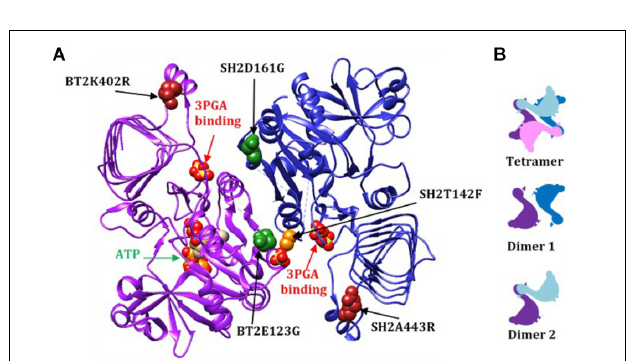
FIGURE 2 | (A) A dimer from the AGPase crystal structure (dimer 1), viewed from the inside of the tetramer demonstrating how the two G α G motifs relate to the two 3PGA binding sites. The 3PGA binding sites are defined by the pair of sulfates from the crystal structure indicated by the red arrows. Here the subunits are designated BT2 (purple ribbon) and SH2 (dark blue ribbon). The ATP in the BT2 active site is indicated by the green arrow. Mutated sites are shown as colored spheres: BT2 E123G (dark green spheres in purple subunit), SH2 D161G (dark green spheres in blue subunit), SH2T142F (light orange spheres in blue subunit), BT2 K402R (dark red spheres in the purple subunit), and SH2 A443R (dark red spheres in the blue subunit). The spheres are from of the published potato crystal structure. (B) Rough two-dimensional diagrams of the tetramer and two dimers of small/large subunits. Small subunits are purple and pink and large subunits are dark and light